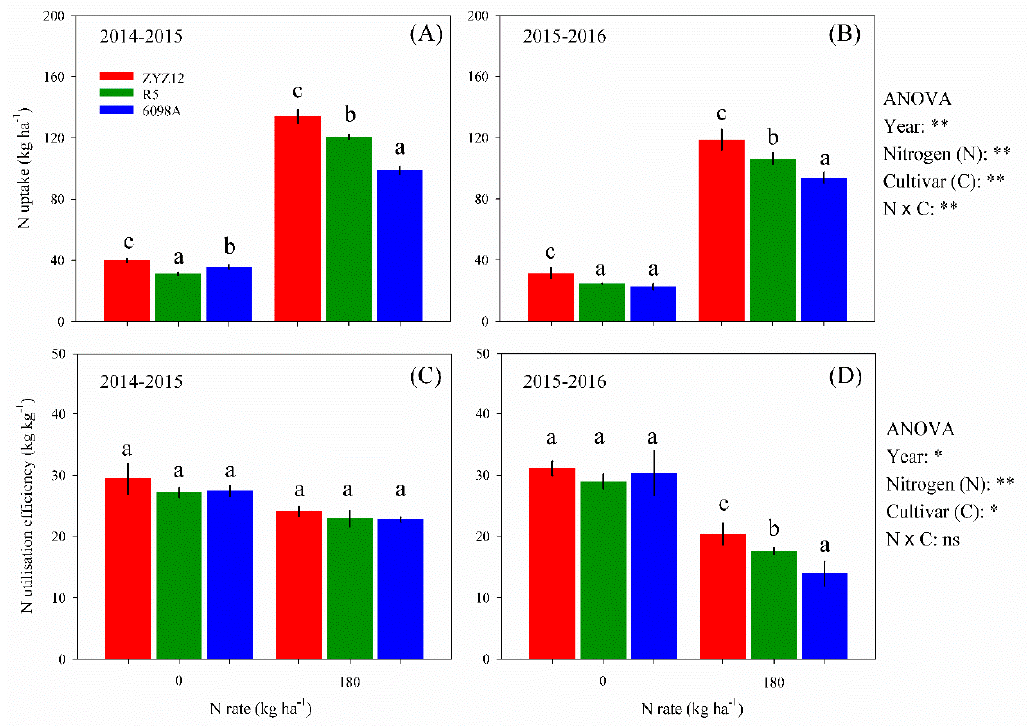
Figure 4. N uptake ( A , B ) and utilization efficiency ( C , D ) of three oilseed rape cultivars grown at two N rates during the two experimental seasons. Bars with different letters are significantly different at a probability level of p < 0.05 within each N rate. ANOVA results are also given. **, p < 0.01; *, p < 0.05; ns, p > 0.05.